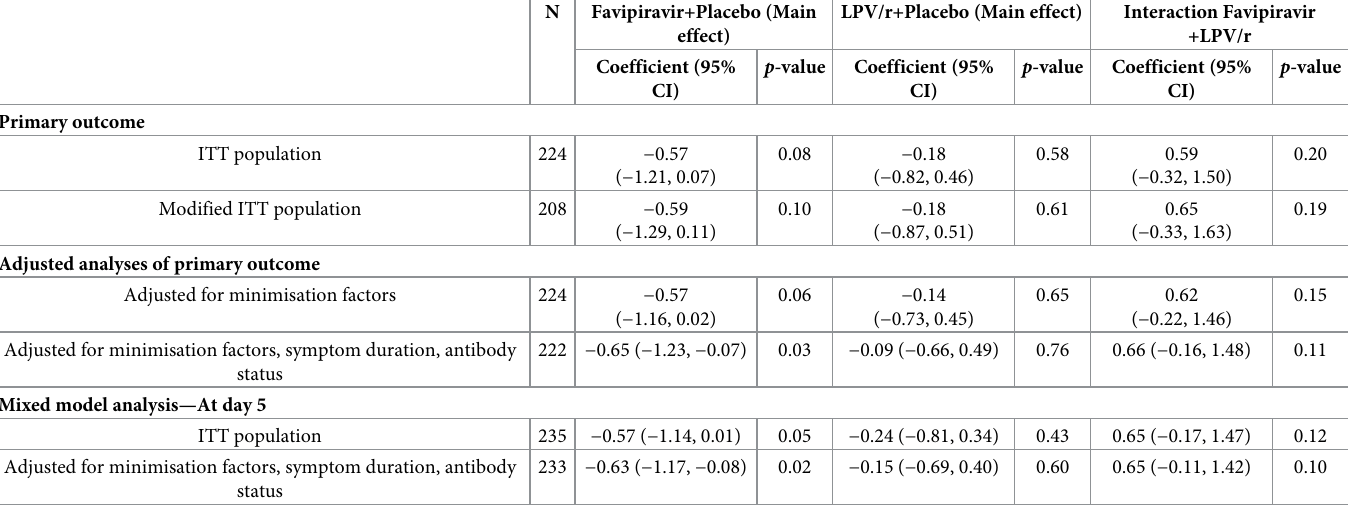
Table 3. Primary outcome analysis: SARS-CoV-2 viral load at Day 5 accounting for baseline viral load.